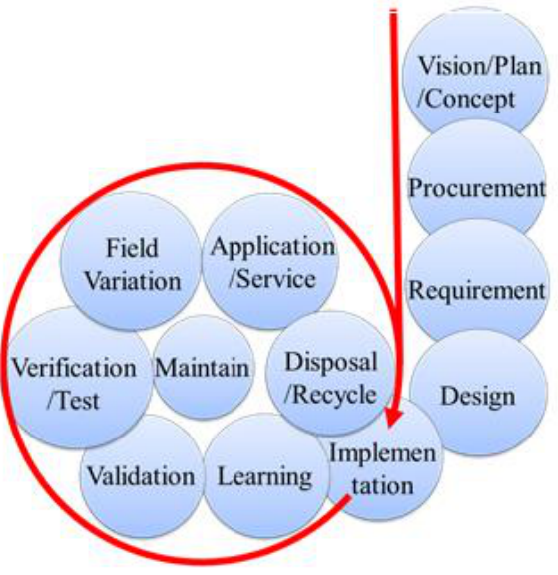
Figure 4. Life cycle of artificial intelligence (AI).